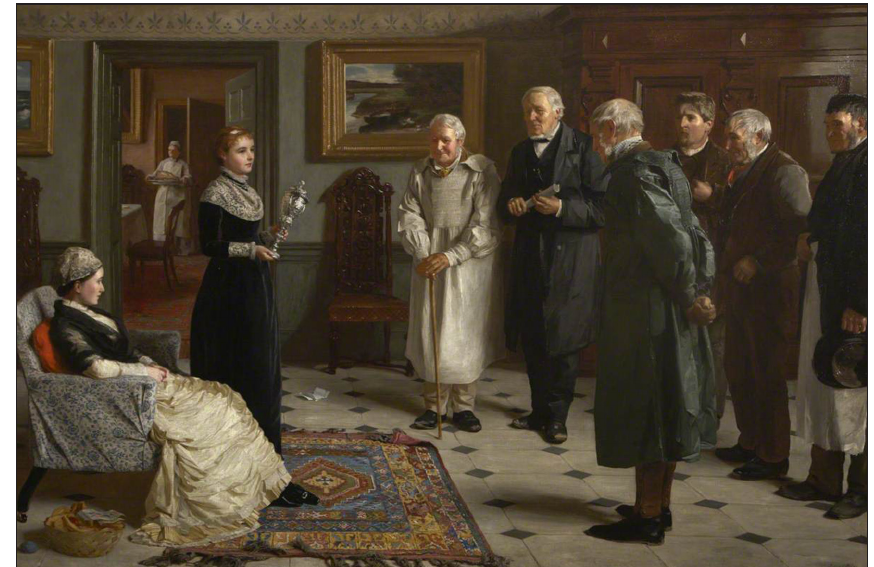
Fig . 7 : James Hayllar, Deputation of Villagers Presenting a Wedding Gift , 1880, oil on canvas, 101 × 152 cm, The Box (Plymouth City